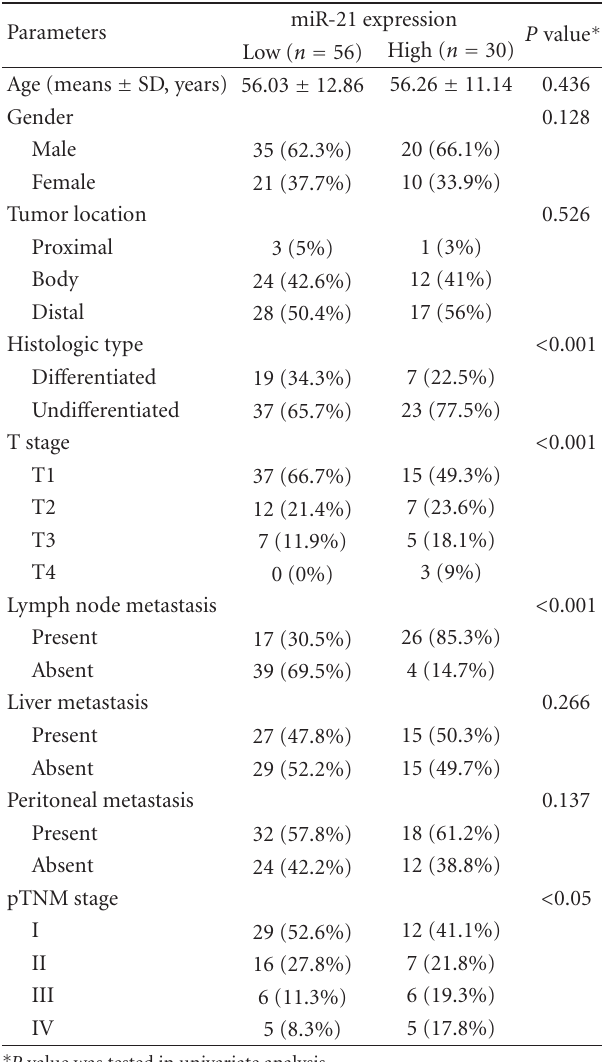
Table 1: Relationship between clinicopathological factors and miR- 21 expression in patients with GC.